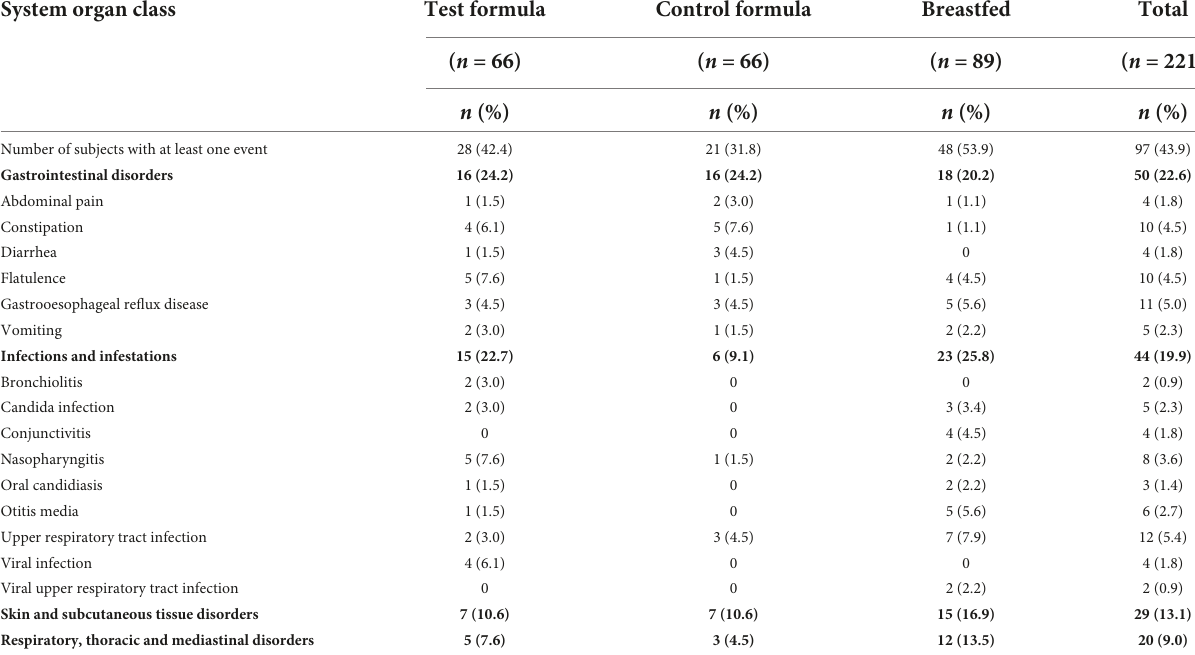
TABLE 6 Adverse events by system organ class and preferred term (safety population). System organ